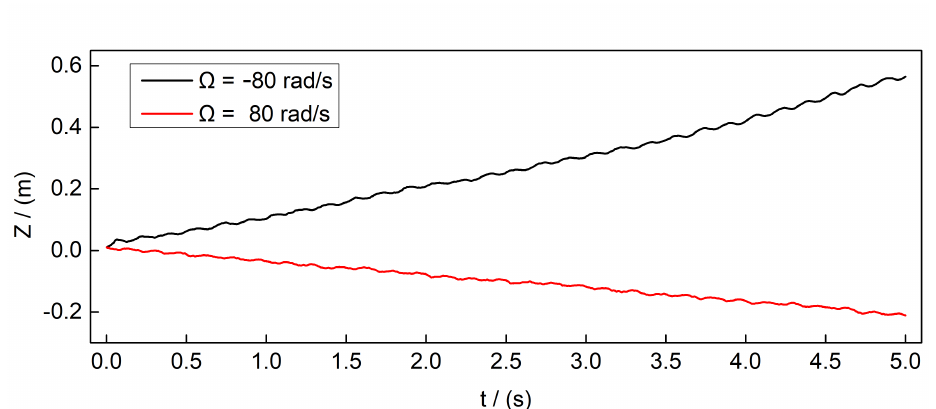
Figure 4. The displacement-time graph describing the locomotion of the SO in the z direction at two opposite rotation angular velocities.